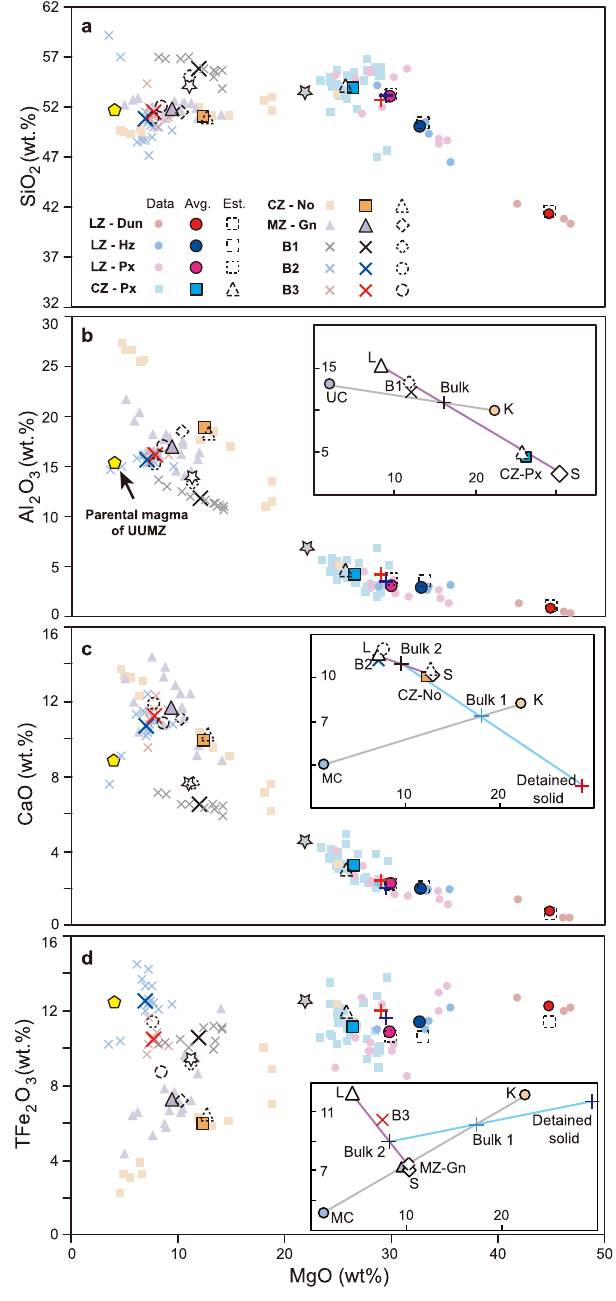
compositions derived from the thermodynamic models. All data collected from multiple sources cited in the text 24,25,40,41 and provided as a Source Data fi